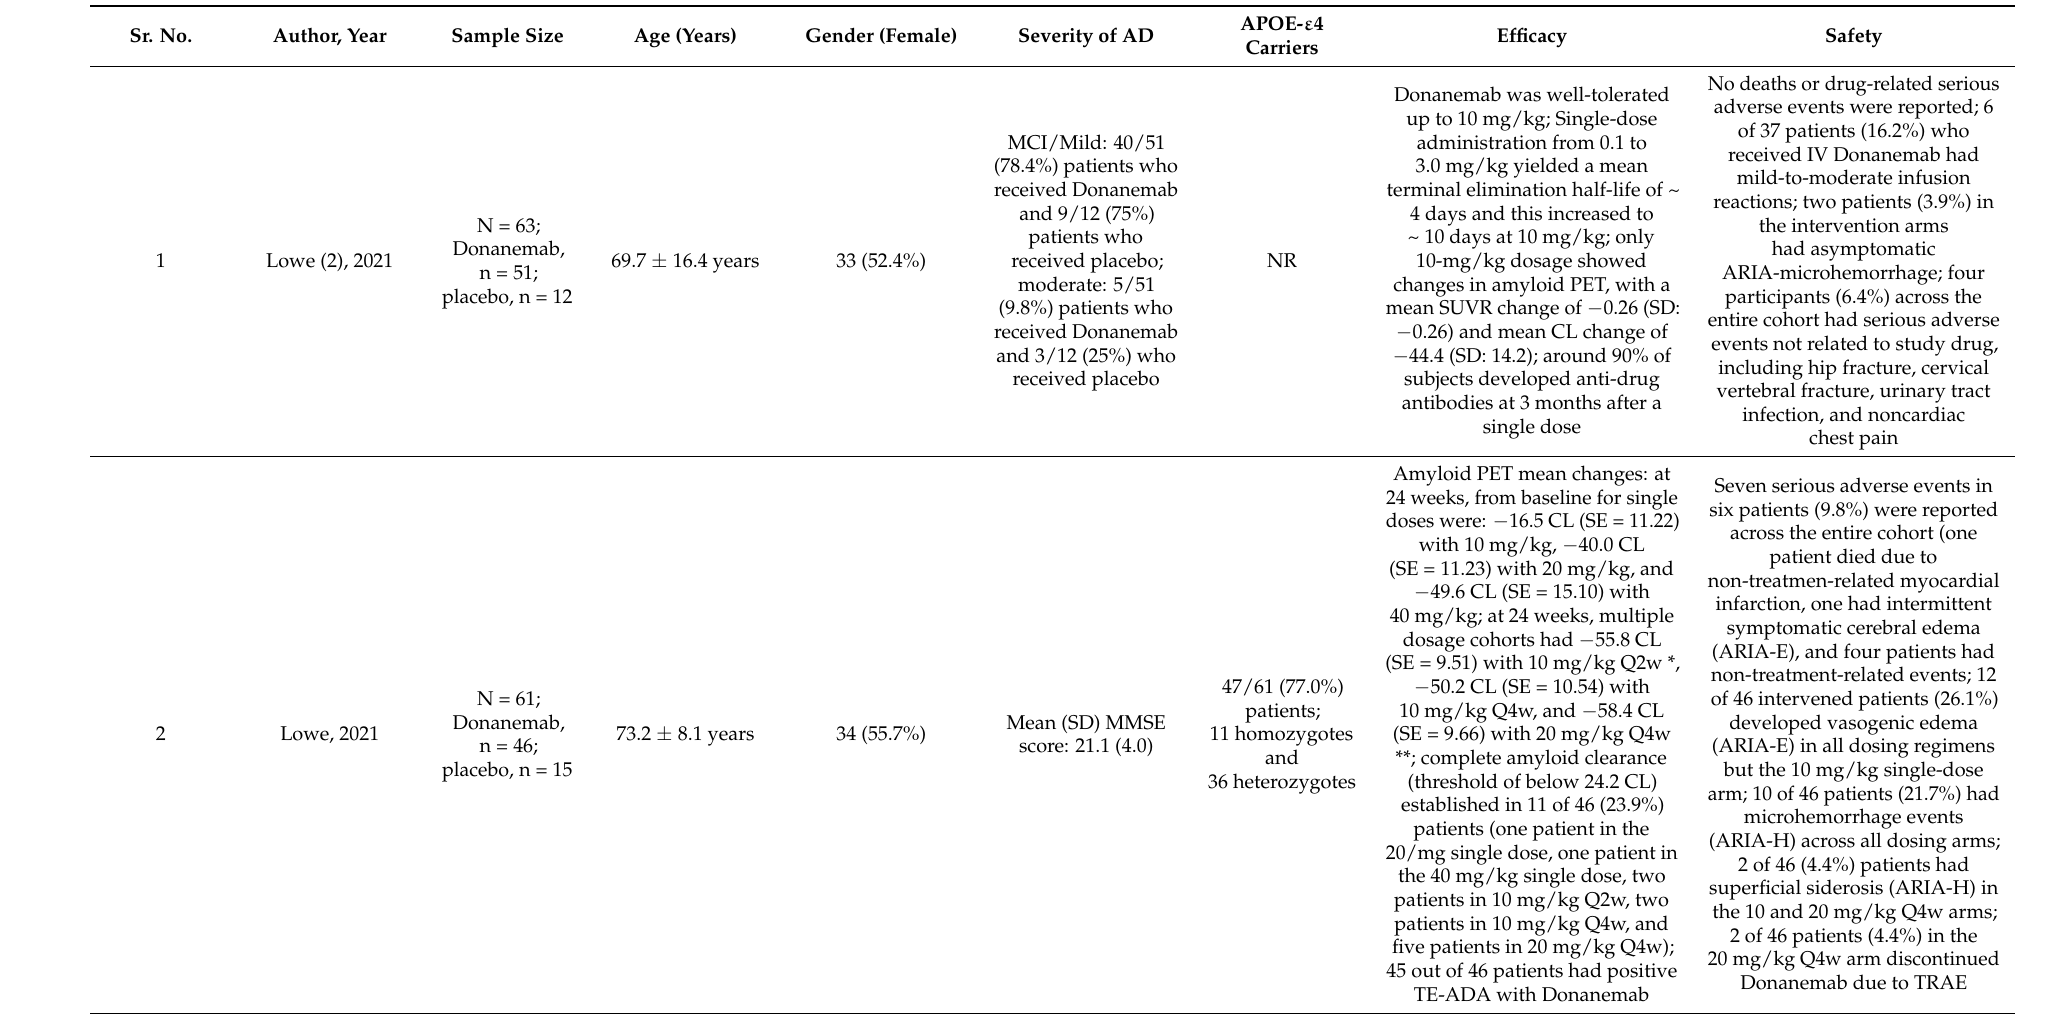
Table 2. Patient characteristics, and efficacy/safety outcomes of the